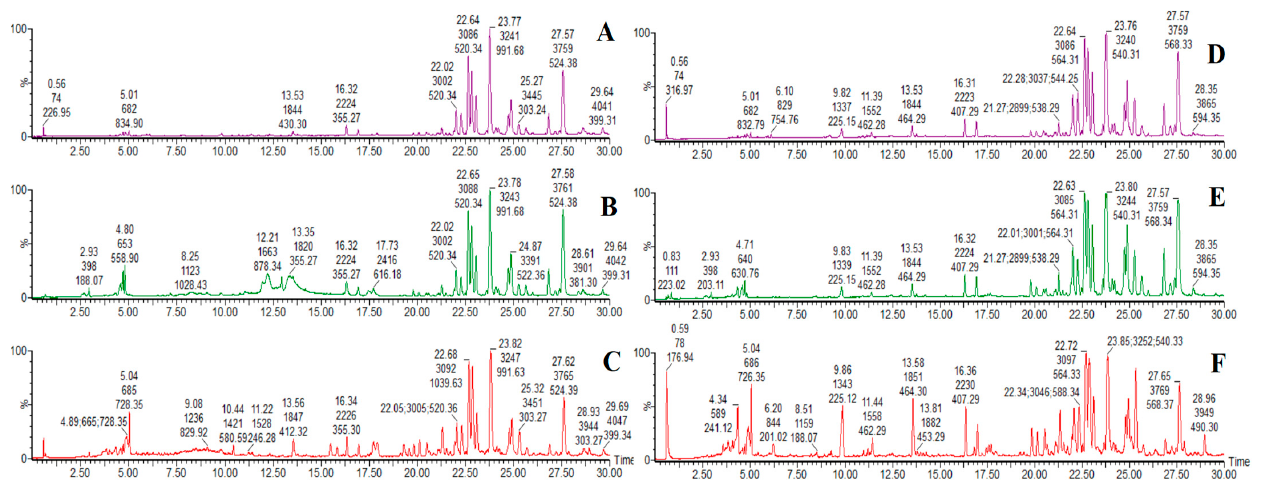
Figure 3. BPI chromatograms of rat serum samples. ( A , B , D , E ): serum samples of DHJS rats after 14 days of treatment with JGCC; ( C , F ): serum samples of DHJS rats; ( A , D ): method 2 to prepare serum samples; ( B , C , E , F ): method 1 to prepare serum samples; ( A – C ): positive ion mode; ( D – F ): negative ion mode.